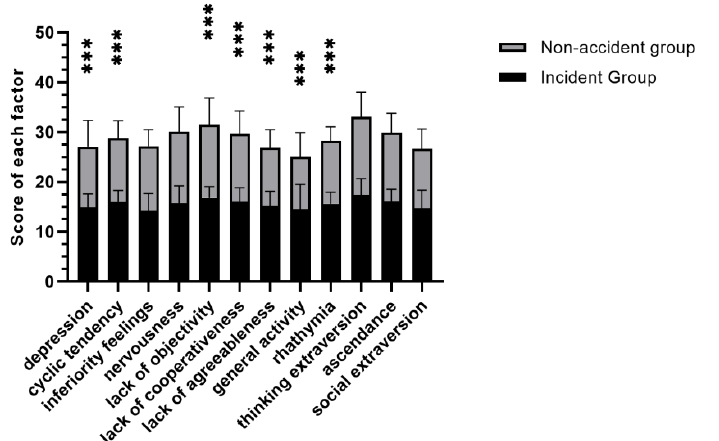
Figure 2. Comparison of the scores of each factor of the Y-G personality scale between drivers in the accident group and non-accident group. Note: *** p < 0.001.